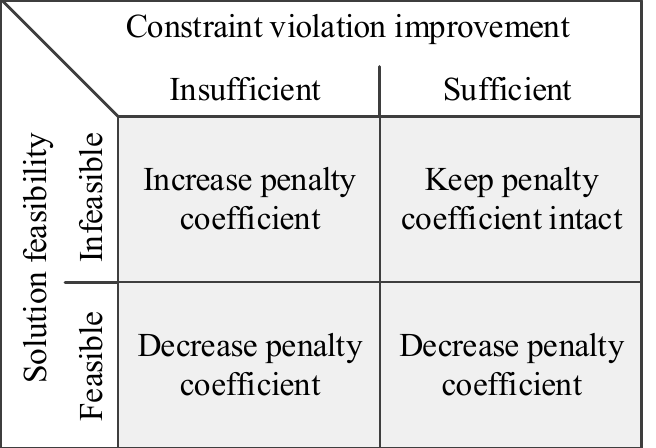
Figure 1. The concept of adaptive adjustment of penalty coefficients. Shown are the four possible situations concerning constraint violation, and the actions undertaken.